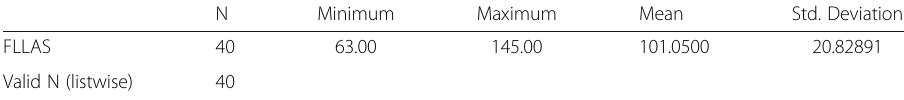
Table 4 Descriptive Statistics of FLLAS